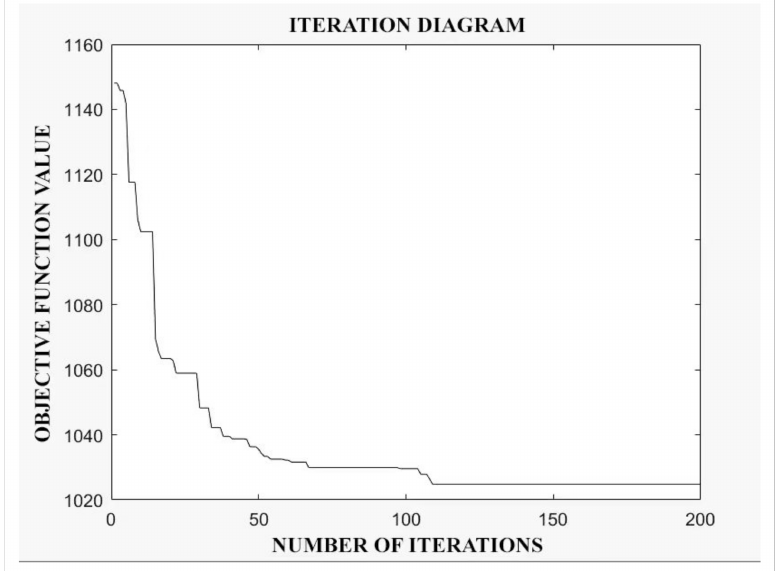
Figure 10. Cost search iteration chart.